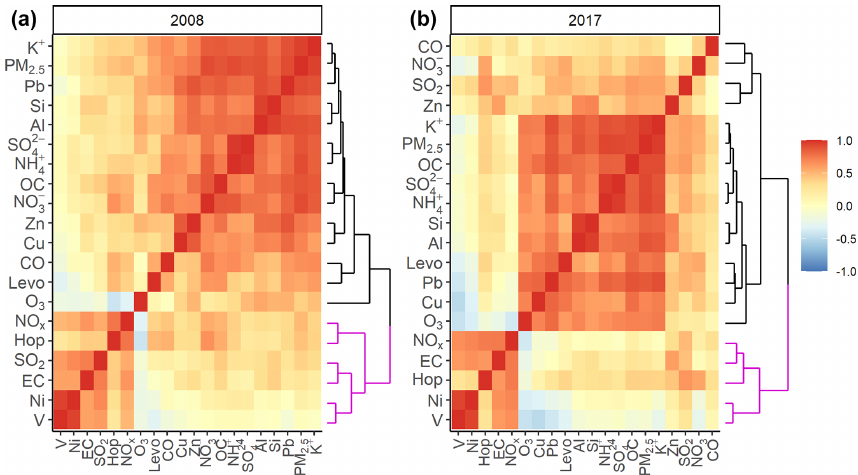
Figure 5. Correlation matrix of gaseous and particulate pollutants with hierarchical clustering results at 2008 (a) and at 2017 (b) . Clusters: pink – local sources; black – regional